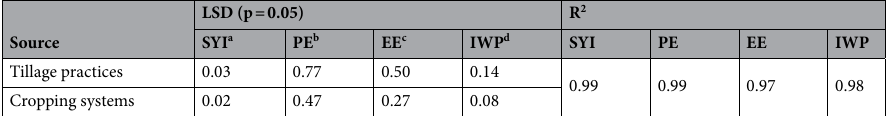
Table 4. ANOVA for a sustainable yield index. b Production efficiency. c Economic efficiency. d Irrigation water productivity.